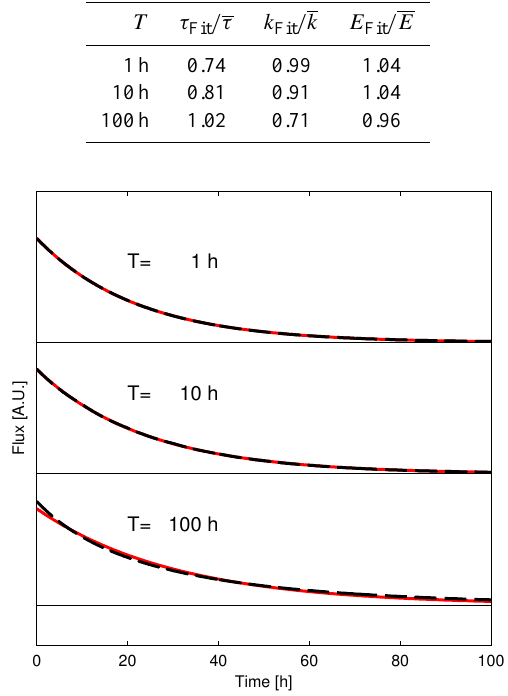
Table 3. Effect of temporal variations of E and τ . For details see text.